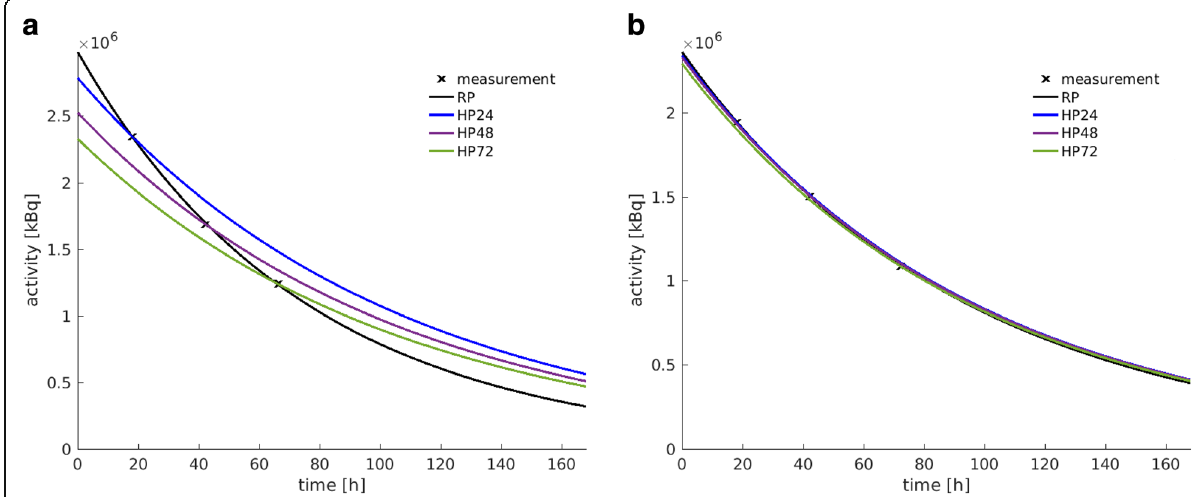
Fig. 6 Whole-body TACs for ( a ) patient P4 (Lu-177-Octreotate) and ( b ) patient P8 (Lu-177-PSMA-617) to visualise the impact of the time point of whole-body planar image acquisition during hybrid-protocol-based calculation of the bone marrow absorbed dose from the ROB (24, 48, or 72 h p. i.)